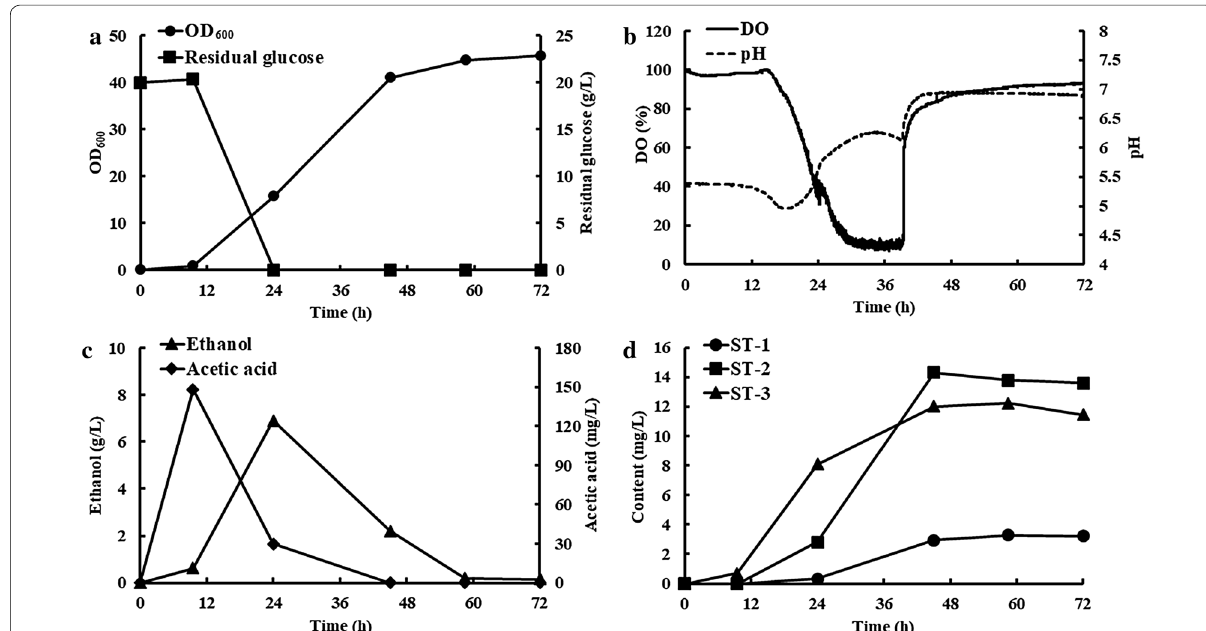
Fig. 2 Fermentation of strain YL-T3-CYP505D13 in 10 L bioreactor. Time profile of a residual glucose and cell growth, b pH and dissolved oxygen (DO), c ethanol and acetate and d accumulation of ST-1, ST-2, and